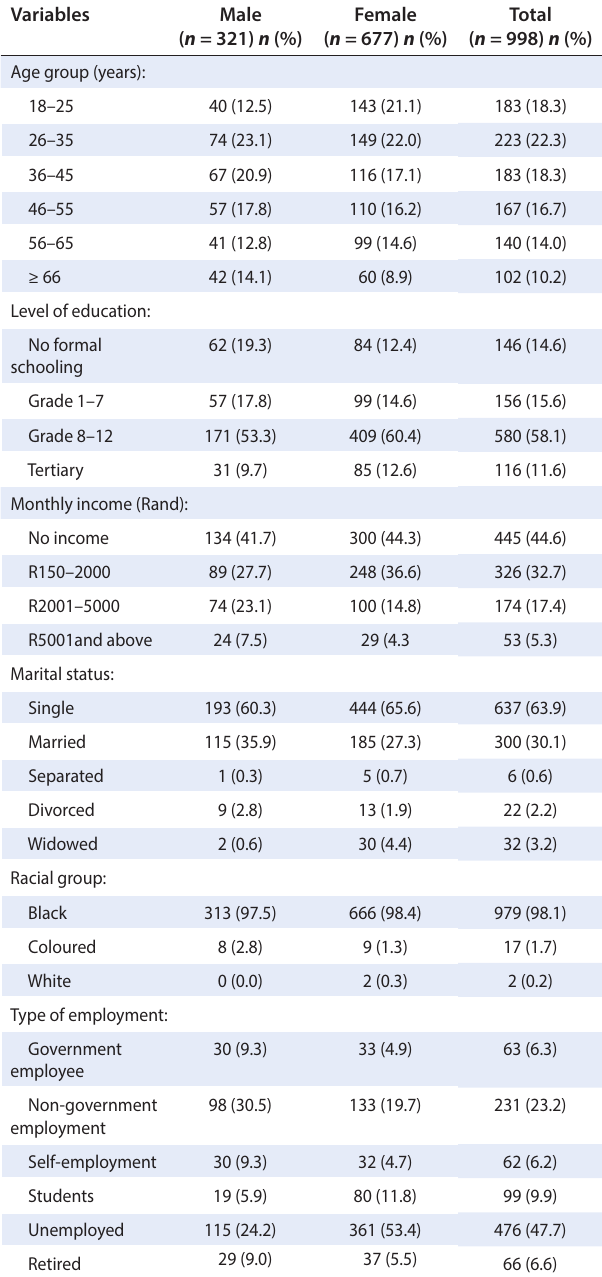
Table 1: Demographic characteristics of the participants by gender